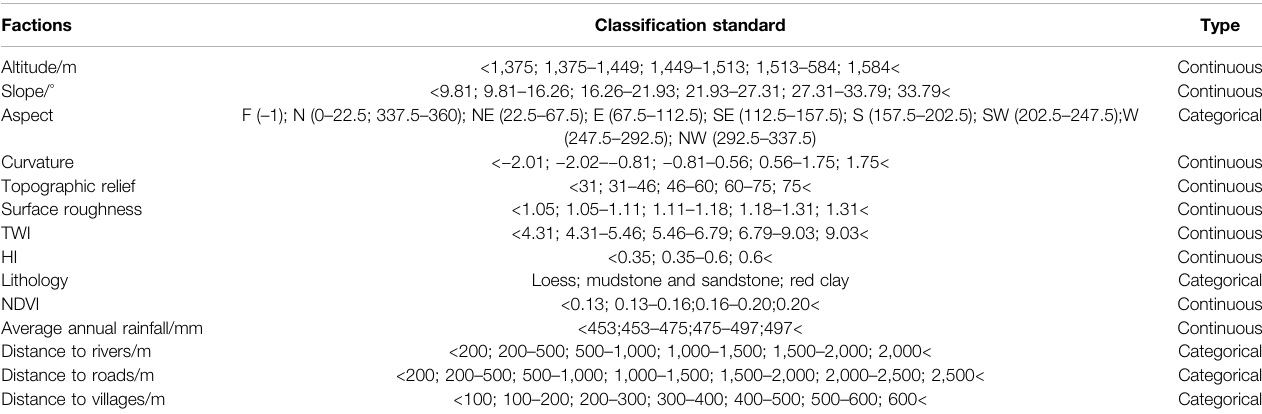
TABLE 1 | In fl uencing factor categories of